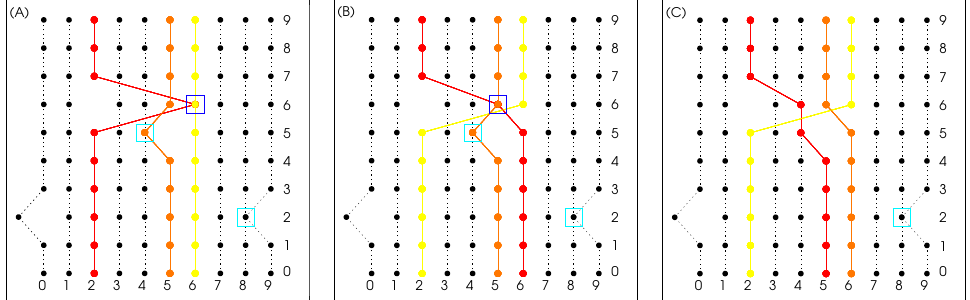
Fig. 1. A two iteration-time lasting avalanche for a small lattice, with driving parameters δ + =4 and δ − =− 1. Strands are numbered from left to right and nodes along a given strand from top to bottom. In panel (A) the strand 5 has suffered a perturbation to the left in node (5, 5) now Fig. 1.— A two iteration-time lasting avalanche for a small lattice, with driving parameters Fig. 1.— A two iteration-time lasting avalanche for a small lattice, with driving parameters Fig. 1.— A two iteration-time lasting avalanche for a small lattice, with driving parameters located at lattice site [4, 5]. In panel (A) node (2, 6) has been displaced four units to the right. Open squares indicate the nodes where two is formed between or more strands meet and form an angle. 2 [ 6 , 6 ] ∼ 2.65 is the angle formed by strands 2 and 6 at site [6, 6]. 2 [ 8 , 2 ]] = π δ = 4 and δ − = − 1. Strands are numbered from left to right and nodes along a given strand δ = 4 and δ − = − 1. Strands are numbered from left to right and nodes along a given strand δ = 4 and δ − = − 1. Strands are numbered from left to right and nodes along a given strand 2 + + + strands 8 and 9 and 2 [ 4 , 5 ] = π is formed by strands 4 and 5. Since for this example 2 C =2.25 the only unstable site is [6, 6]. 2 from top to bottom. In panel (A) the strand 5 has suffered a perturbation to the left in node from top to bottom. In panel (A) the strand 5 has suffered a perturbation to the left in node from top to bottom. In panel (A) the strand 5 has suffered a perturbation to the left in node In panel (B) site [6, 6] is no longer unstable. Strands 2 and 6 have reconnected and the node (6, 6) belonging to strand 2 has been displaced to the left. With this displacement a new unstable site appears at [5, 6] with 2 [ 5 , 6 ] ∼ 2 . 35 formed by strands 5 and 6. (5 , 5) now located at lattice site [4 , 5]. In panel (A) node (2 , 6) has been displaced four units (5 , 5) now located at lattice site [4 , 5]. In panel (A) node (2 , 6) has been displaced four units (5 , 5) now located at lattice site [4 , 5]. In panel (A) node (2 , 6) has been displaced four units In panel (C) the instability has been eliminated: strands 5 and 6 have reconnected and the node (5, 6) belonging to strand 5 has moved one to the right. Open squares indicate the nodes where two or more strands meet and form an to the right. Open squares indicate the nodes where two or more strands meet and form an to the right. Open squares indicate the nodes where two or more strands meet and form an unit to the left. At this point there are no more unstable nodes in the lattice and perturbation re-starts. ∼ 2 . 65 is the angle formed by strands 2 and 6 at site [6 , 6]. Θ angle. Θ = π is formed ∼ 2 . 65 is the angle formed by strands 2 and 6 at site [6 , 6]. Θ angle. Θ = π is formed ∼ 2 . 65 is the angle formed by strands 2 and 6 at site [6 , 6]. Θ angle. Θ = π is formed [6 , 6] [8 , 2]] [6 , 6] [8 , 2]] [6 , 6] [8 , 2]] 2 2 2 between strands 8 and 9 and Θ = π is formed by strands 4 and 5. Since for this example between strands 8 and 9 and Θ = π is formed by strands 4 and 5. Since for this example between strands 8 and 9 and Θ = π is formed by strands 4 and 5. Since for this example [4 , 5] [4 , 5] [4 , 5] flares usually originates from lower down, as charged parti- 2 2 2 Θ = 2 . 25 the only unstable site is [6 , 6]. In panel (B) site [6 , 6] is no longer unstable. Strands Θ = 2 . 25 the only unstable site is [6 , 6]. In panel (B) site [6 , 6] is no longer unstable. Strands Θ = 2 . 25 the only unstable site is [6 , 6]. In panel (B) site [6 , 6] is no longer unstable. Strands cle accelerated at the reconnection sites are channelled down- C C C ward and thermalize in the lower corona and 2 and 6 have reconnect-ed /and the node (6 , 6) belonging to strand 2 has been displaced 2 and 6 have reconnect-ed /and the node (6 , 6) belonging to strand 2 has been displaced 2 and 6 have reconnect-ed /and the node (6 , 6) belonging to strand 2 has been displaced ∼ 2 . 35 ∼ 2 . 35 to the left. With this displacement a new unstable site appears at [5 , 6] with Θ to the left. With this displacement a new unstable site appears at [5 , 6] with Θ ∼ 2 . 35 to the left. With this displacement a new unstable site appears at [5 , 6] with Θ [5 , 6] [5 , 6] [5 , 6] formed by strands 5 and 6. In panel (C) the instability has been eliminated: strands 5 and formed by strands 5 and 6. In panel (C) the instability has been eliminated: strands 5 and formed by strands 5 and 6. In panel (C) the instability has been eliminated: strands 5 and 6 have reconnected and the node (5 , 6) belonging to strand 5 has moved one unit to the left. 6 have reconnected and the node (5 , 6) belonging to strand 5 has moved one unit to the left. 6 have reconnected and the node (5 , 6) belonging to strand 5 has moved one unit to the left. At this point there are no more unstable nodes in the lattice and perturbation re-starts. At this point there are no more unstable nodes in the lattice and perturbation re-starts. At this point there are no more unstable nodes in the lattice and perturbation re-starts.